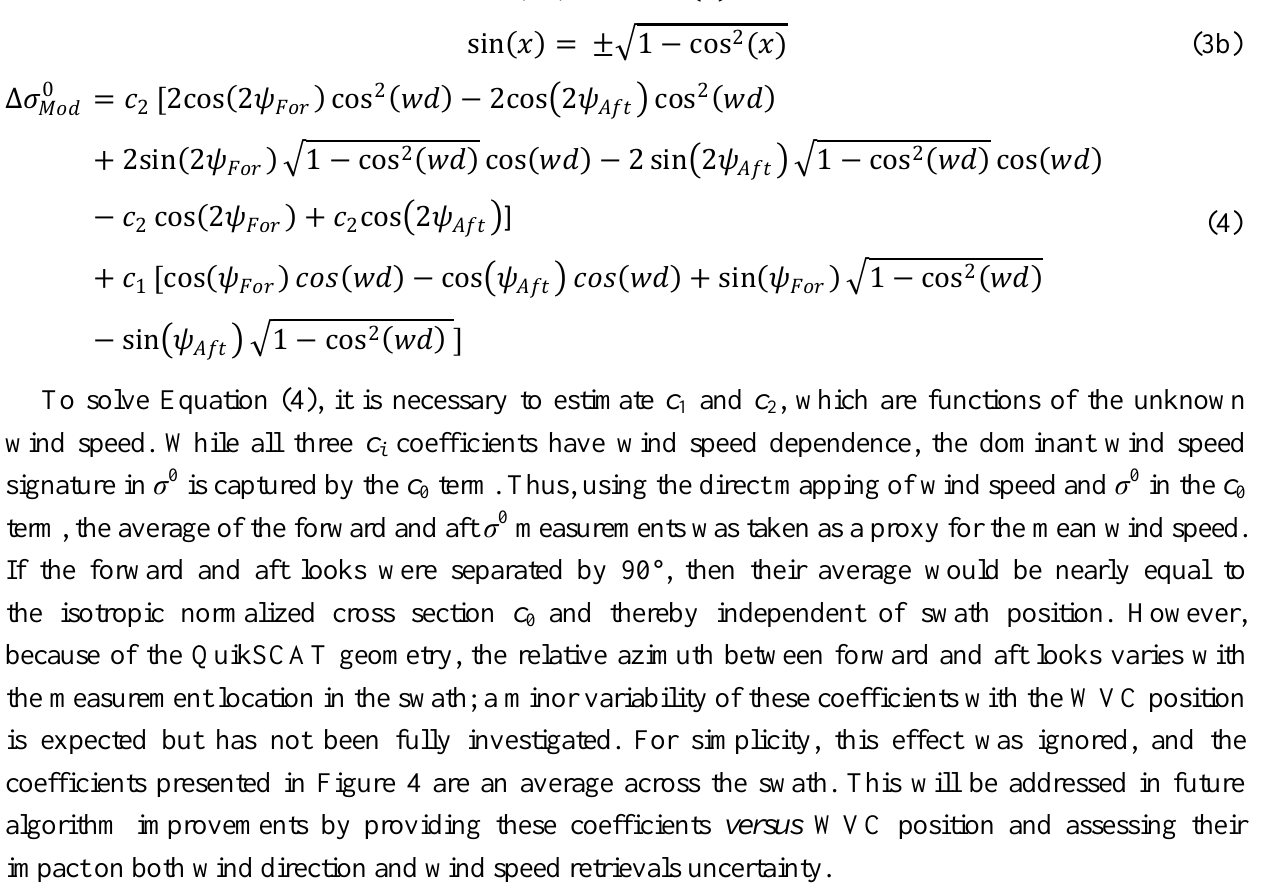
Figure 4. The coefficients ( a ) c